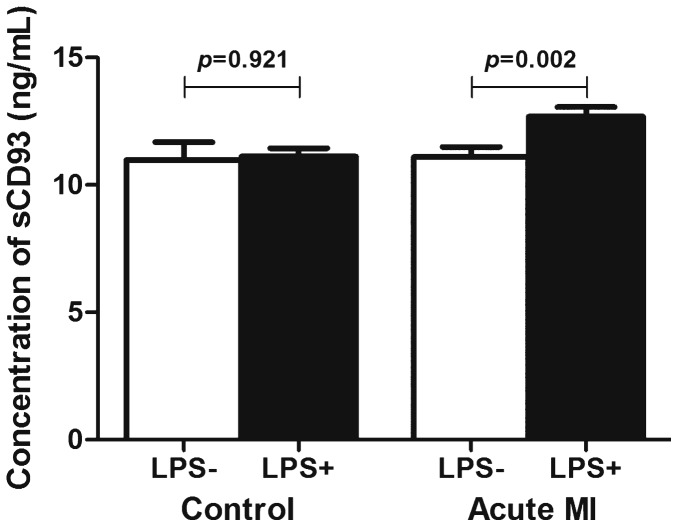
Increased amount of sCD93 in supernatant after LPS stimulation in acute MI patients.